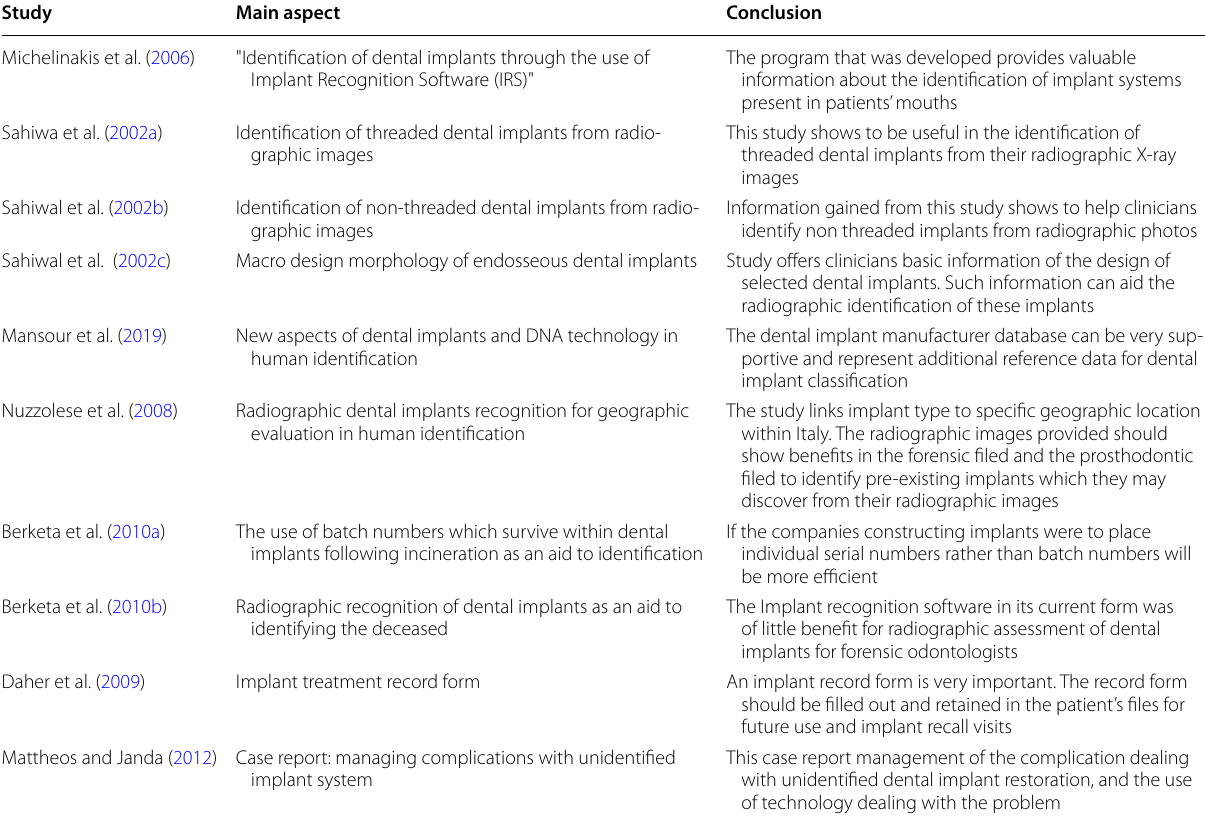
Table 1 Implant identification studies included in this study (Michelinakis et al. 2006; Sahiwal et al. 2002a, b, c;